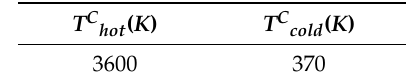
Table 3. Combustion gases and coolant bulk temperatures.